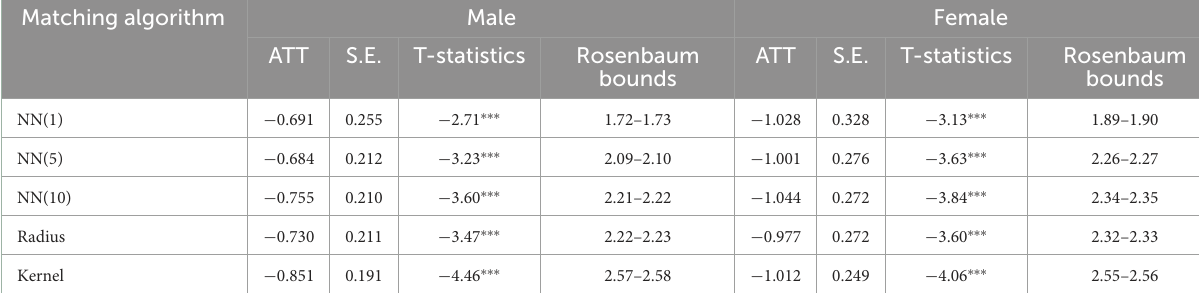
TABLE 6 Heterogeneity in health impacts of internet use by gender. Matching